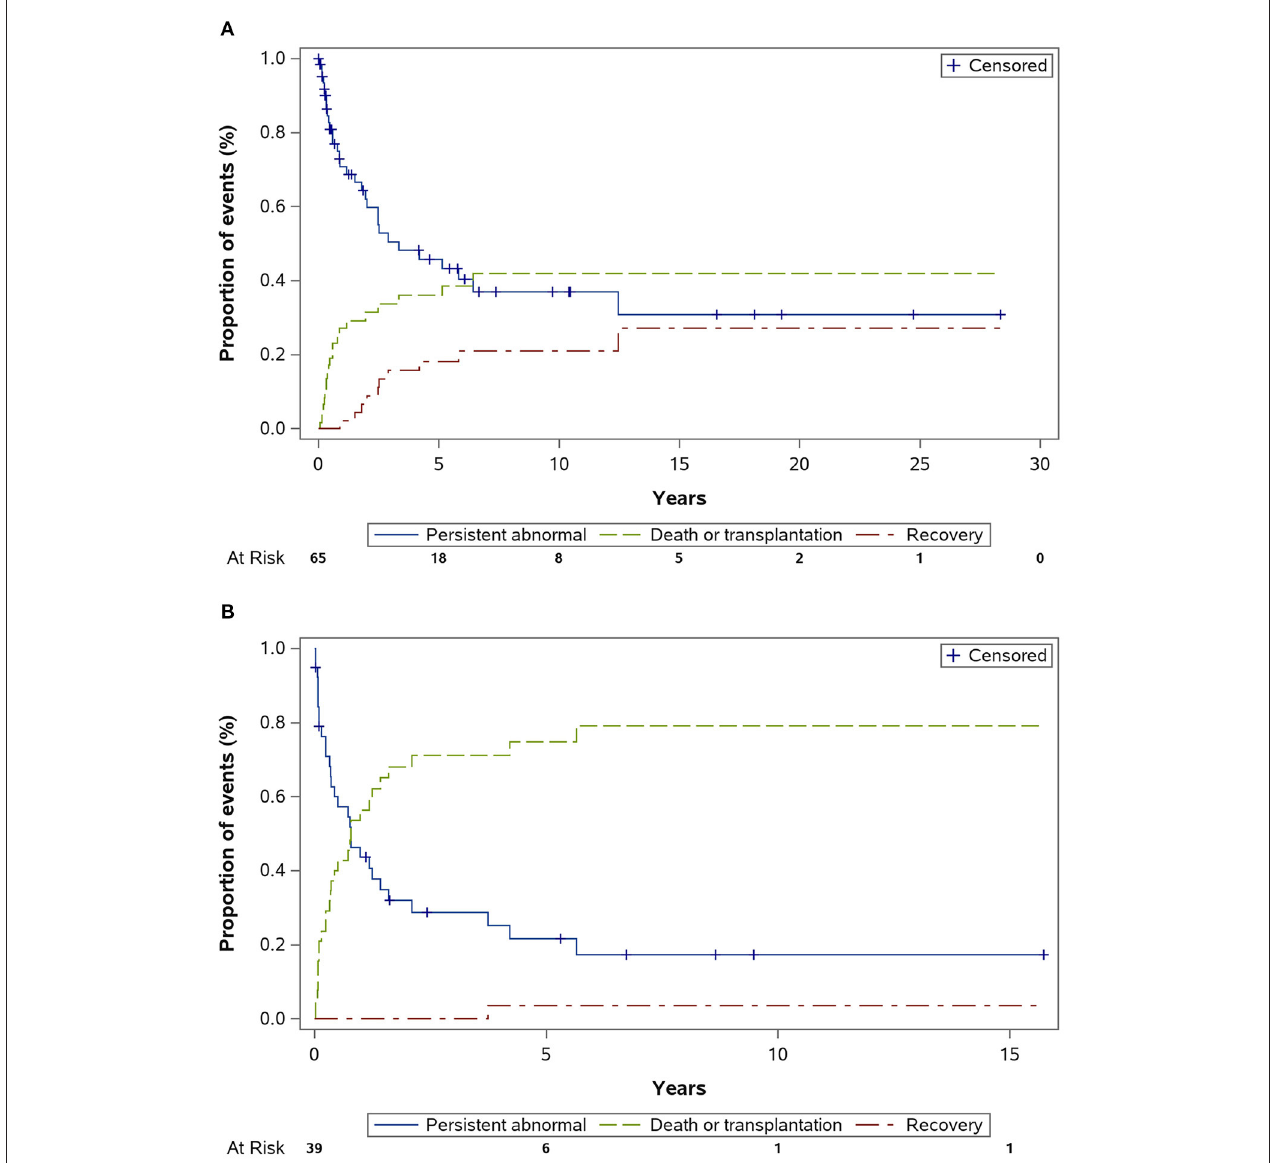
FIGURE 3 | Cumulative incidence of left ventricular normalization (recovery) by age. (Competing risk factors, death or transplant). Estimated cumulative incidence rate of recovery was higher in those diagnosed before age 3 years (A) than those diagnosed after age 3 years (B) , P = 0.028.